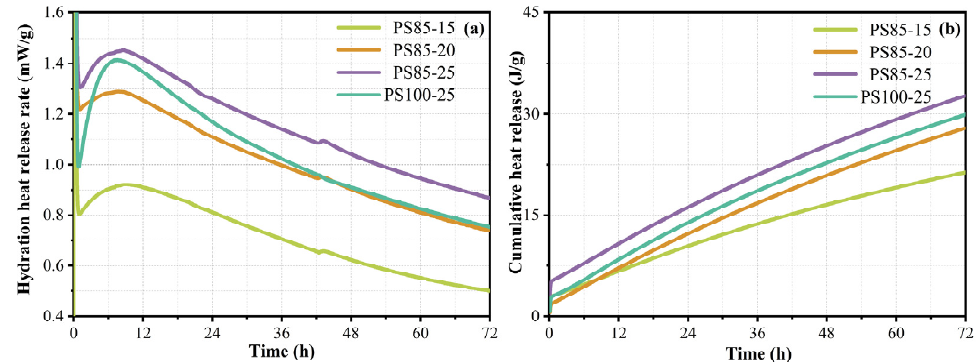
Figure 1. Hydration heat curves of WUFA-PS and PS-based geopolymers: ( a ) rate of heat release and ( b ) cumulative heat release.